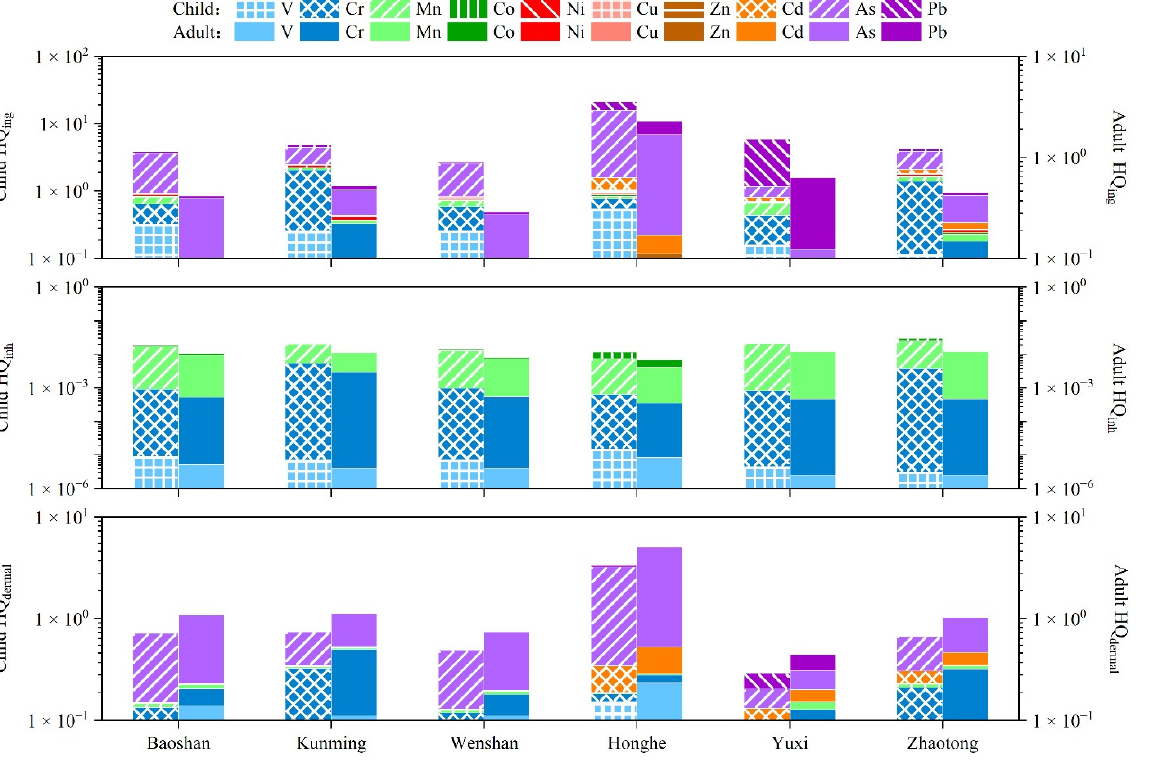
Table 6. Carcinogenic risk of potentially toxic elements in PM 2.5 of soil fugitive dust.